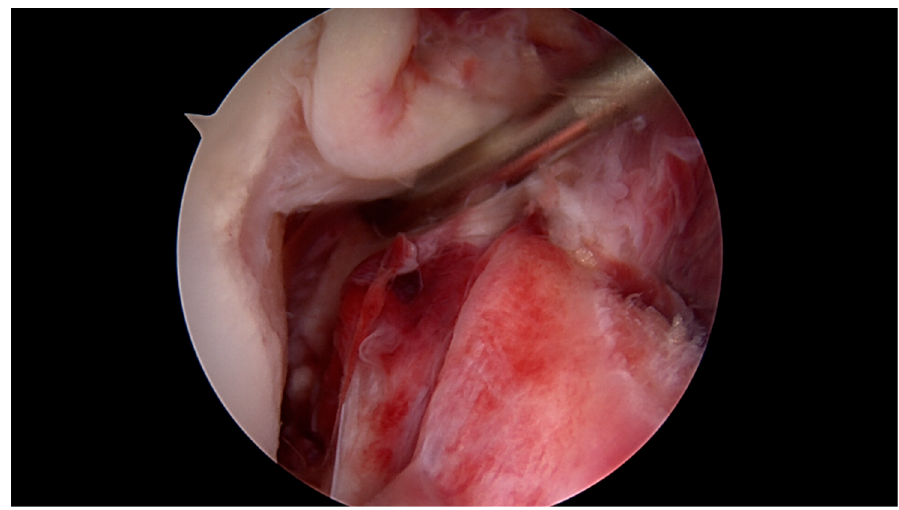
Figure 2. Proximal ACL tear 5 h after injury with excellent tissue quality and intact synovial coverage of the ACL remnant.